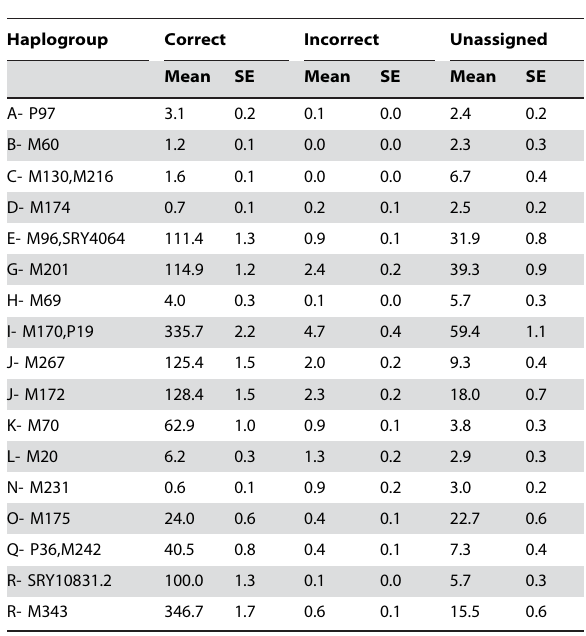
The far right column gives the number of samples with an unassigned tandem classification—all four methods did not